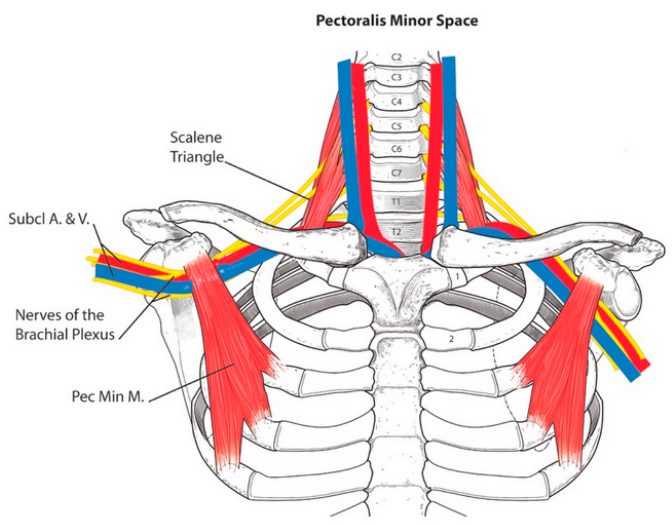
Figure 1. The anatomy of thoracic outlet and pectoralis minor areas. The scalene triangle is above the clavicle. Between the anterior and middle scalene muscles are the five nerve roots and trunks of the brachial plexus and the subclavian artery. The subclavian vein runs anterior to the triangle. Below the clavicle the axillary artery and vein lie immediately under the pectoralis minor muscle. The cords and branches of the brachial plexus usually surround the axillary artery. Figure 1 is reprinted with permission from Sanders R.J. and Haug C.E.: Thoracic outlet syndrome: A common sequela of neck injuries; Lippincott: Philadelphia, PA, USA [2]. Abreviations: Subcl A.&V., subclavian artery and vein; Pec Min M., pectoralis minor muscle.